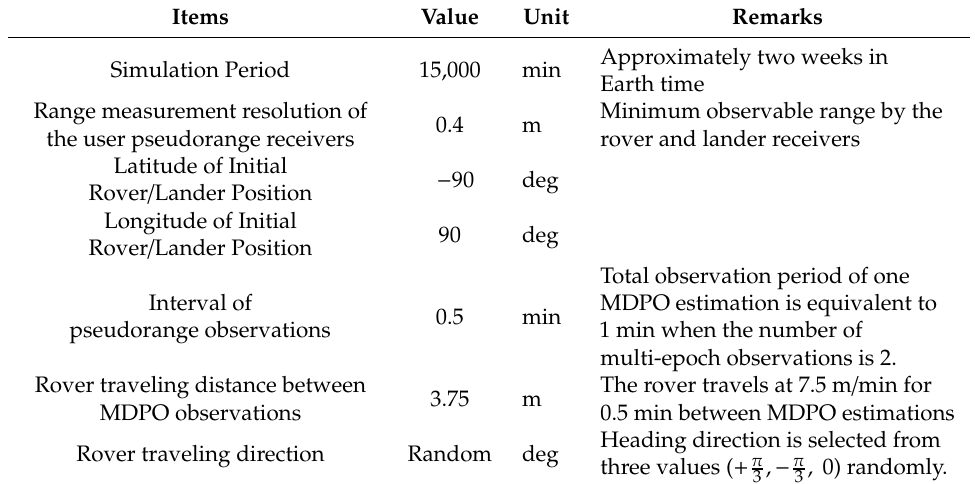
Table 2. Simulation parameters.